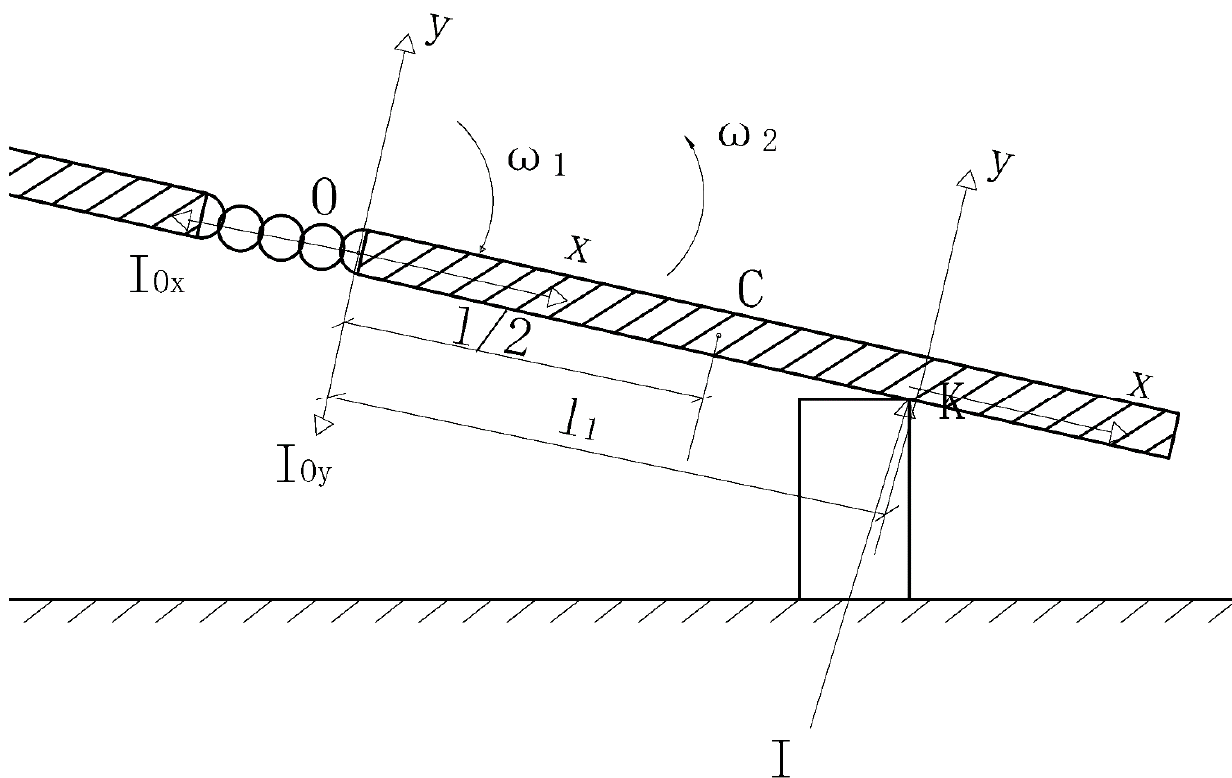
Figure 5. Schematic diagram of force analysis of three-section cudgel last section stick striking fixed object.